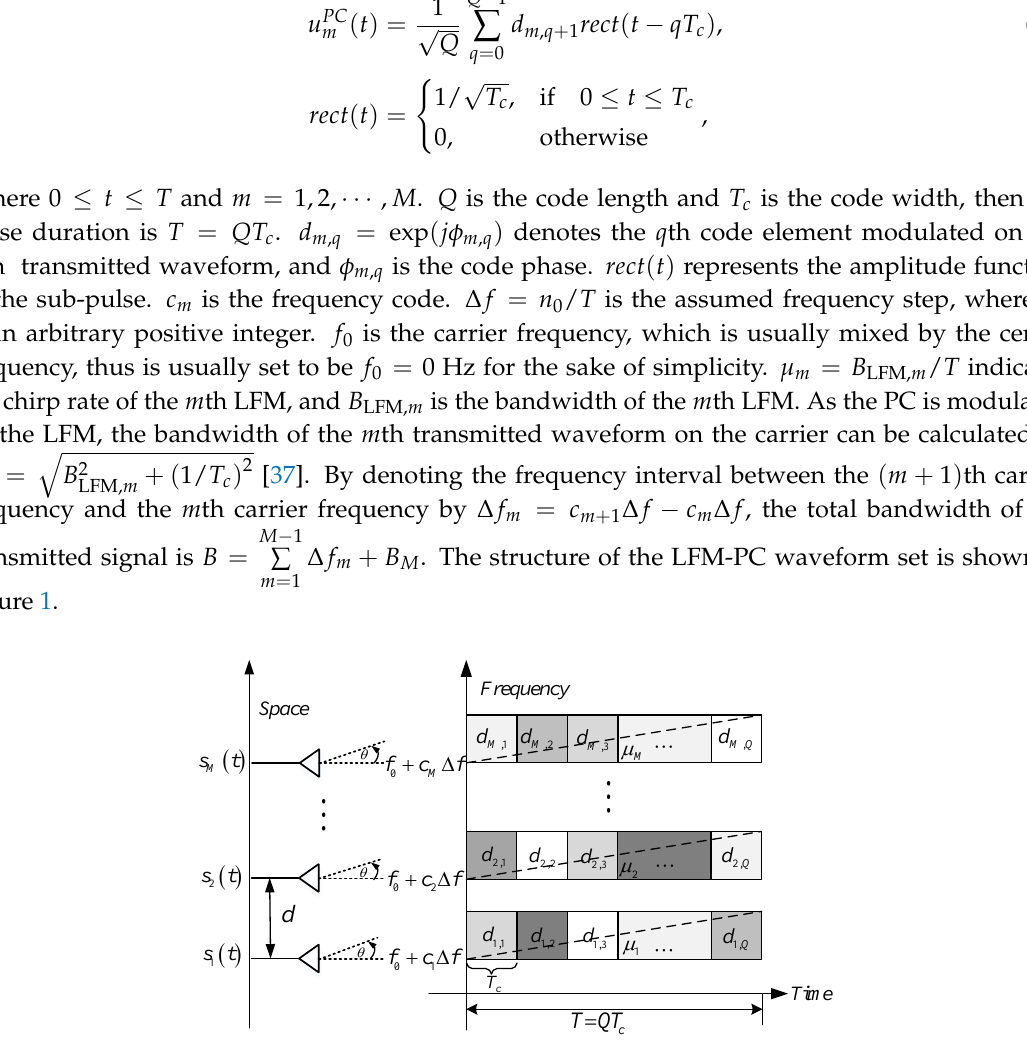
Figure 1. The structure of the linear frequency modulation-phase coded (LFM-PC) waveform